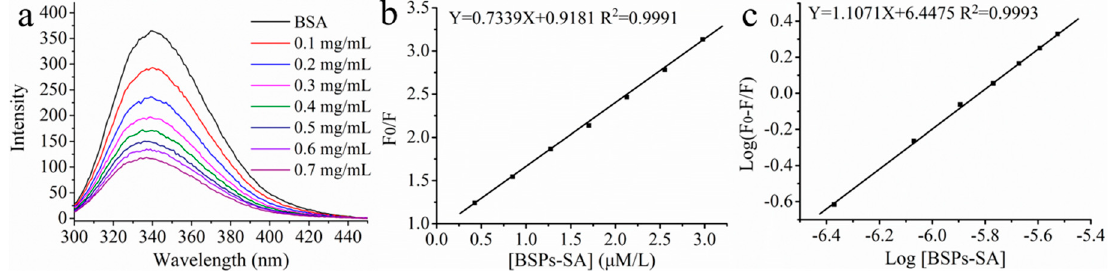
Figure 10. The fluorescence spectra ( a ) of bovine serum albumin (BSA) in a series of concentrations of BSPs-SA nanoparticles in deionized water ( T = 298 K, λ ex = 293 nm). ( b ) The Stern–Volmer plots for the binding of BSPs-SA nanoparticles with bovine serum albumin. ( c ) Plots of log ( F 0 - F / F ) vs. log [BSPs-SA] at 298 K. ( n = 3). The concentration of bovine serum albumin remained constant at 0.33 mg/mL. F 0 and F are the fluorescence intensities at 340 nm in the absence and presence of BSPs-SA, respectively.